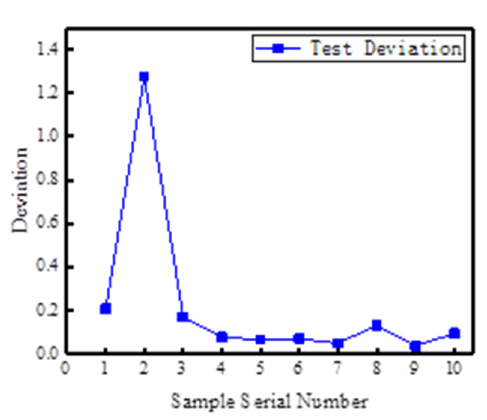
Figure 14. The network model evaluates the absolute error graph.